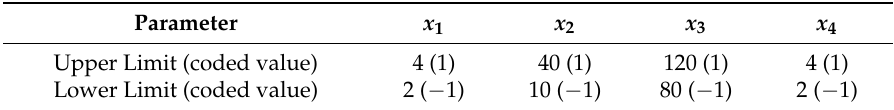
Table 4. HGA variable coding for the biofuel case study.